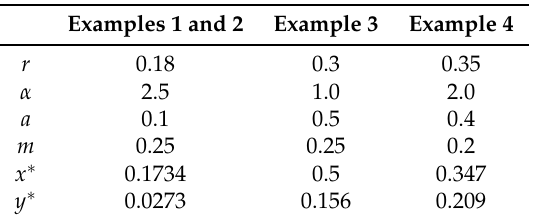
Table 2. Parameter values adopted in the reported Examples. For the other parameters the fixed values remain as those reported in Table 1. The equilibrium value ( x ∗ , y ∗ ) is also